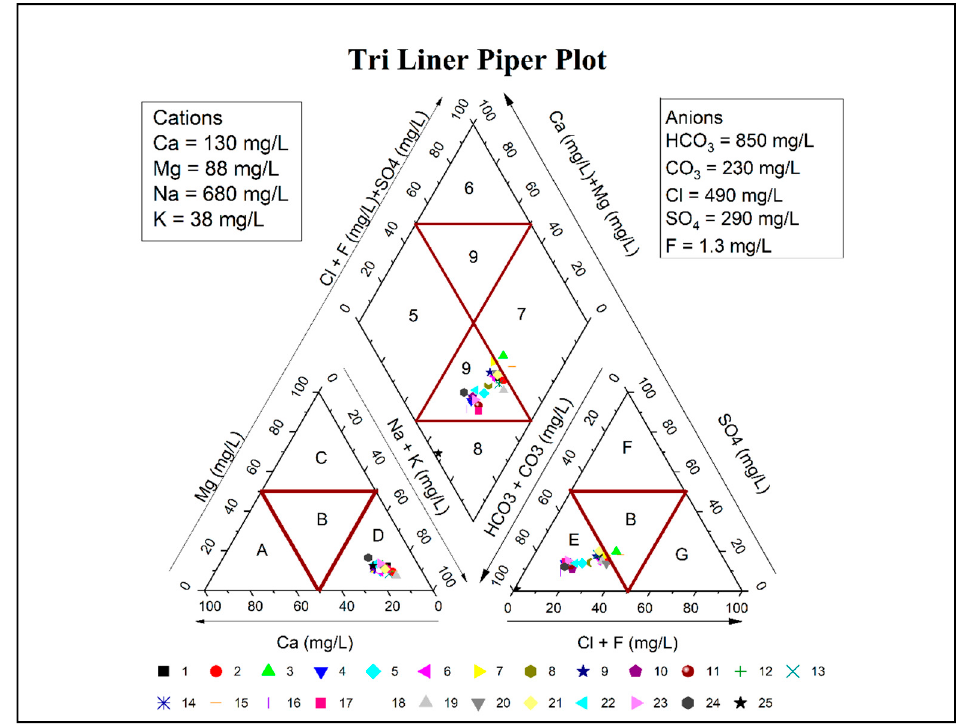
Figure 6. Piper plot for cations and anions. Table 5. Hydro-chemical facies on the basis of piper plot.